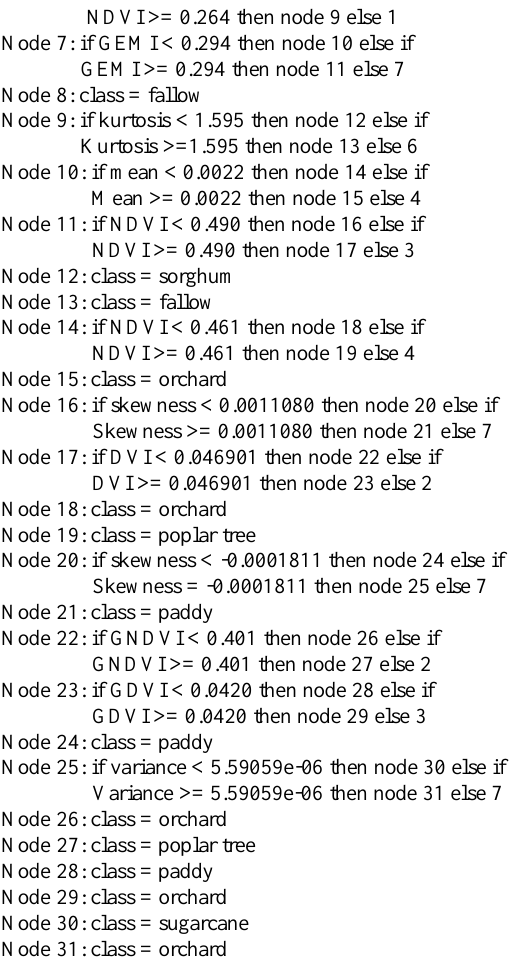
Figure 7. Classified image using decision tree (VI)